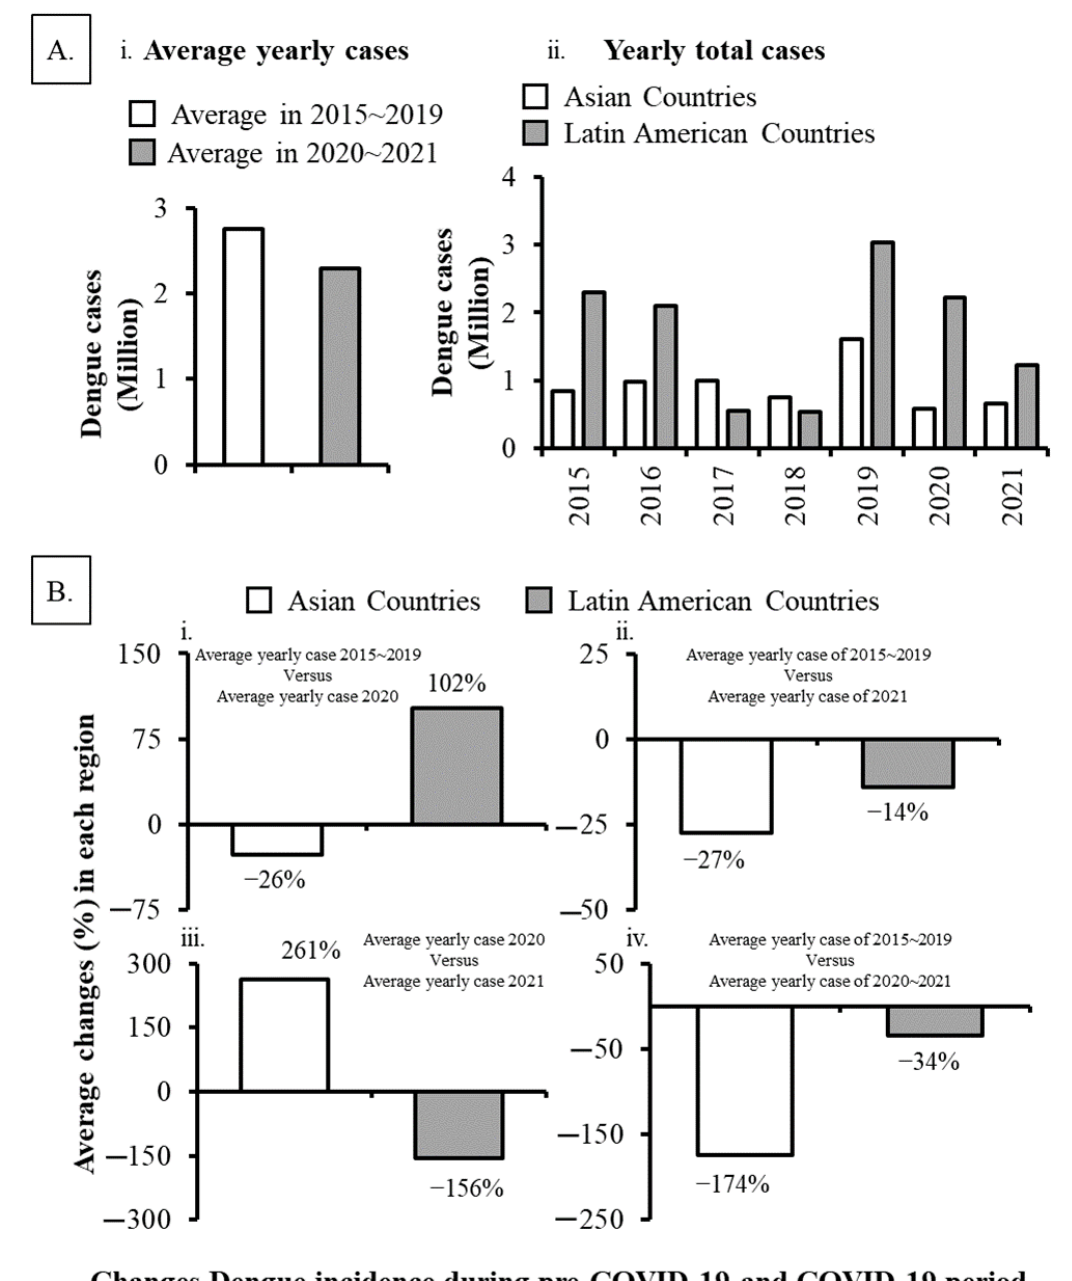
Figure 3. Dengue infection patterns in Asia verse Latin America during the pre-COVID-19 time (2015~2019) and COVID-19 period (2020~2021). ( A ) ( i ) Average dengue incidences in both regions during the pre-COVID-19 time and COVID-19 period. ( ii ) Epidemiological diversities of dengue incidences from year to year in Asia and Latin America from 2015 to 2021. ( B ) ( i − iv ) Average change of dengue incidences in each region during the pre-COVID-19 time and COVID-19 period.